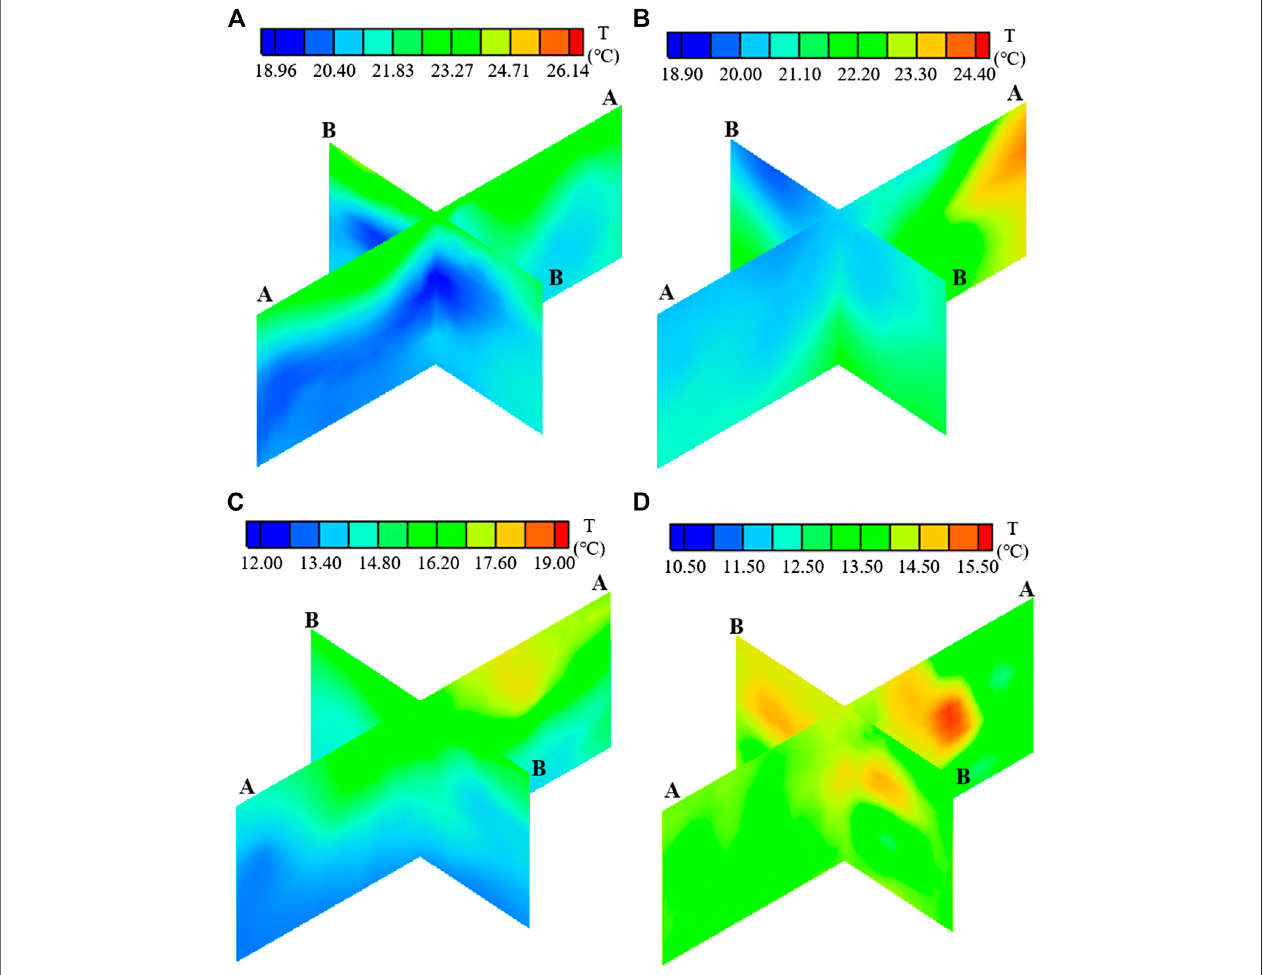
FIGURE13| Thethermal fi eldinsectionA-AandB-Bintheconcrete blocks12#-0033, 0034,0035and0036: (A) May1,2019; (B) Aug1,2019; (C) Nov1,2019; (D) Jan 1, 2020.